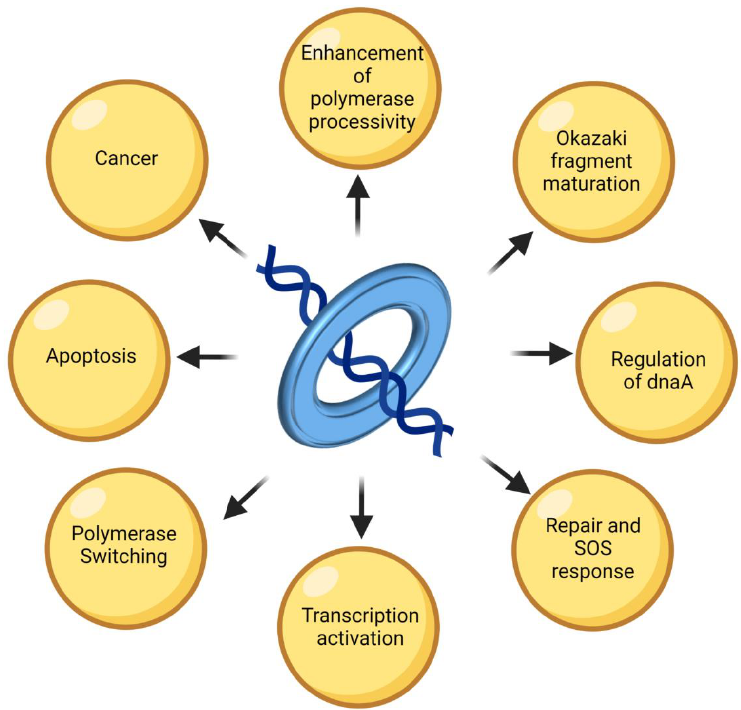
Figure 6. The many roles of a sliding clamp. The image shows the many physiological processes in which the sliding clamp is involved in bacteriophages, prokaryotes, and eukaryotes. The image was created with www.biorender.com (accessed on 28 September 2022).